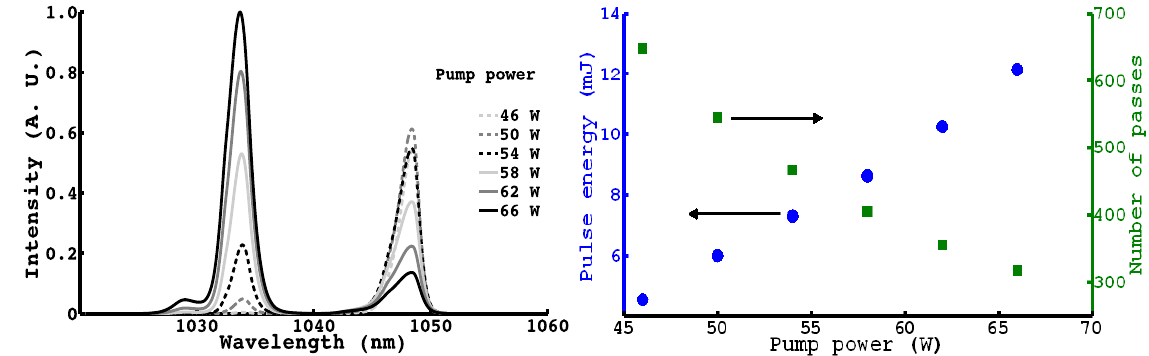
Figure 2. Simulation of free-running cavity based in Yb:CaF wavelength for a range of pump power; right: output energy and required number of passes vs . pump